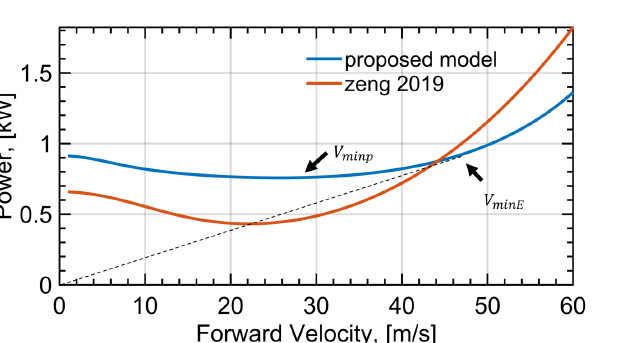
Figure 3. The forward speed V versus propulsion power p . Following an increase in V , p decreases firstly and then increases due to aerodynamic effects. The blue curve represents the proposed model and the red curve represents the model in